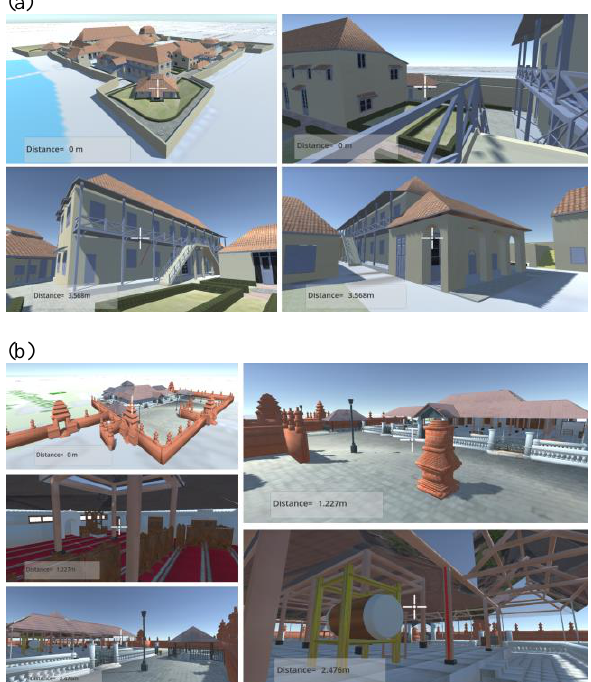
Figure 16. Interactive 3D model at Vredeburg Fort Museum (a) and Kotagede Great Mosque